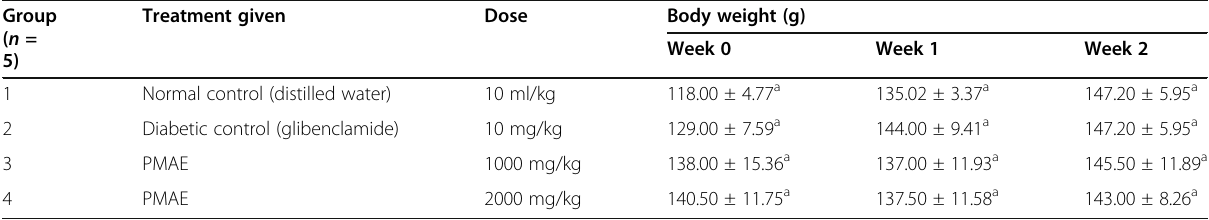
Table 2 Effect of aqueous stem bark extract of P. macrophylla on body weight in alloxan-induced diabetic Wistar rats Group ( n = 5)